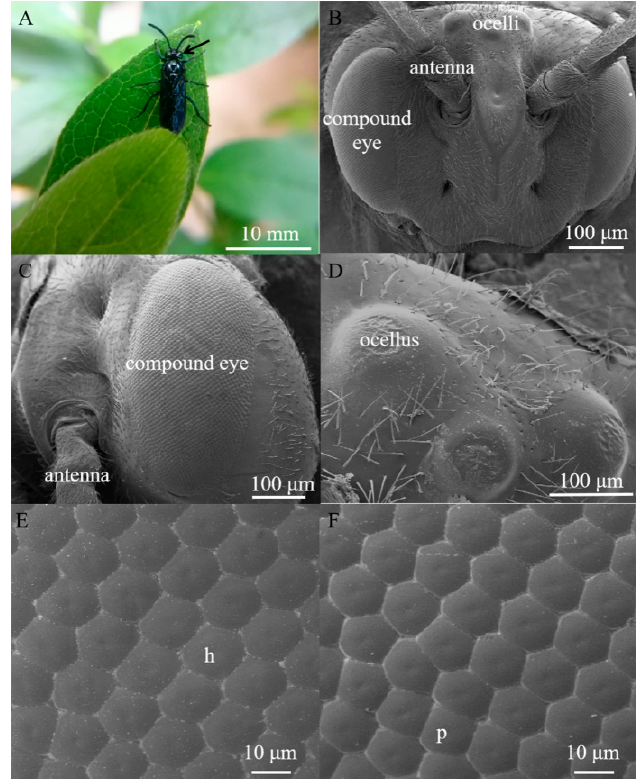
Figure 1. ( A ) Female adult of Arge similis , with compound eye position indicated by the black arrow. ( B ) Scanning electron micrograph of frontal view of the head, showing the position of compound eyes and ocelli. ( C ) Scanning electron micrograph of the lateral view of the compound eye showing little variation of sizes across the eye. ( D ) Scanning electron micrograph of the dorsal ocelli. ( E ) A close-up micrograph of the array of mostly hexagonal facets (h). ( F ) A close-up micrograph with some irregularly shaped and pentagonal facets (p).